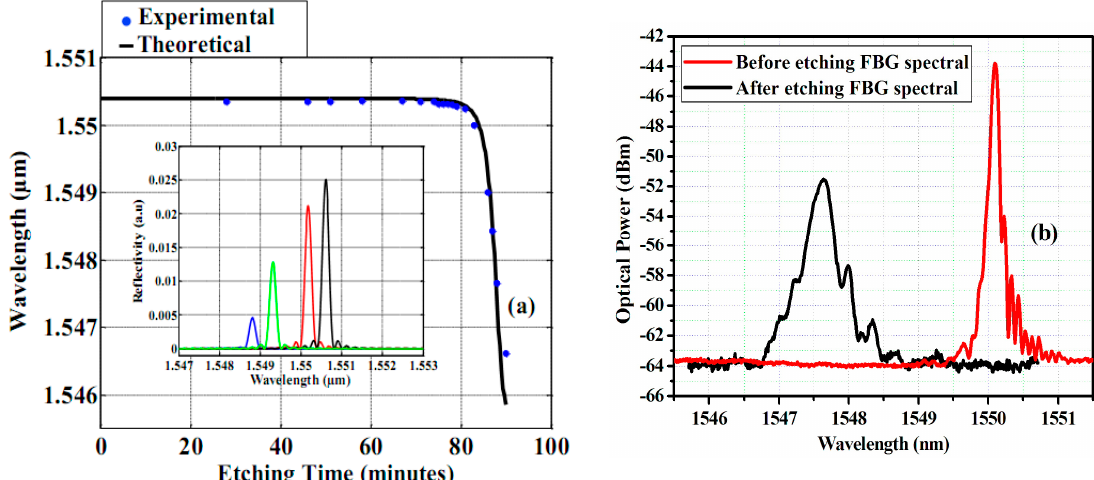
Figure 2. ( a ) Wavelength shift of FBG versus the etching time; and ( b ) reflected spectra of FBG before and after etching process.